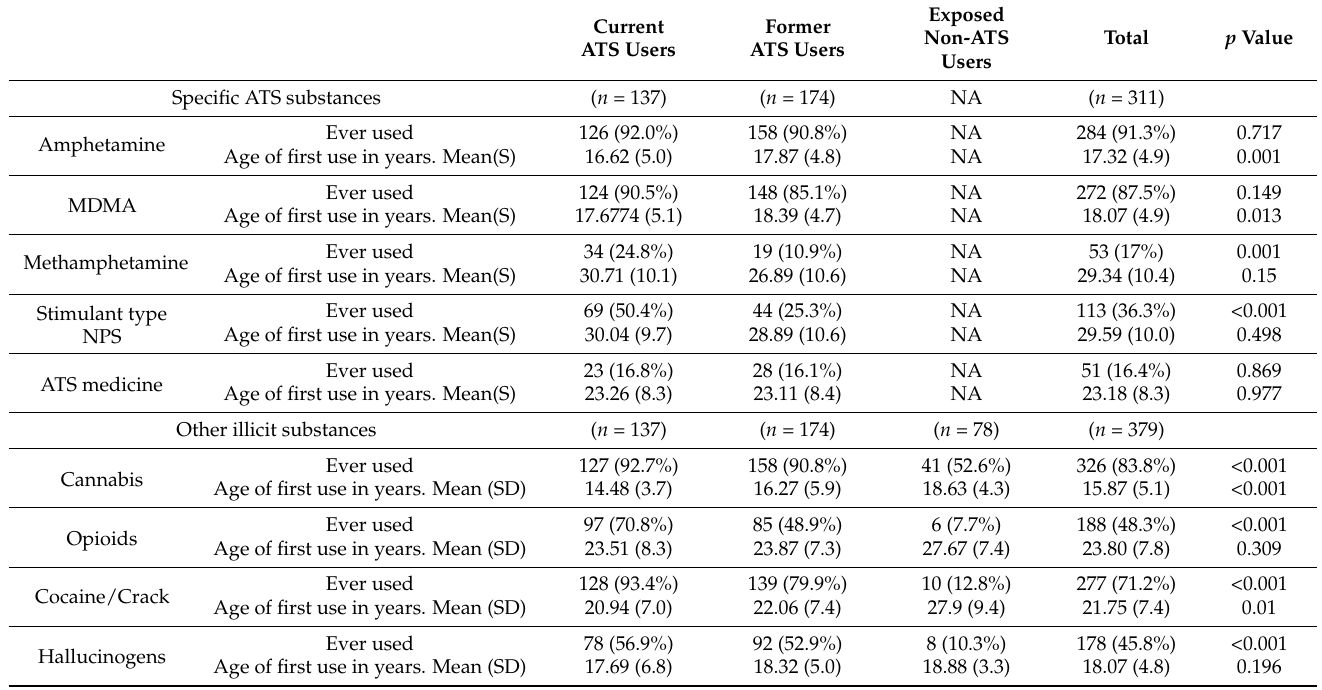
Table 3. Lifetime prevalence and mean age (years) of first use of specific ATS substances and other illicit substances 1 .